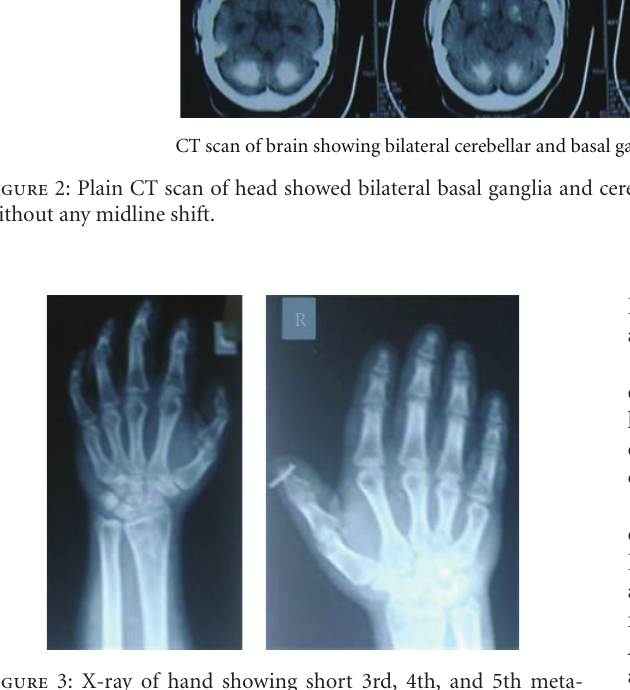
Figure 3: X-ray of hand showing short 3rd, 4th, and 5th meta- carpals.